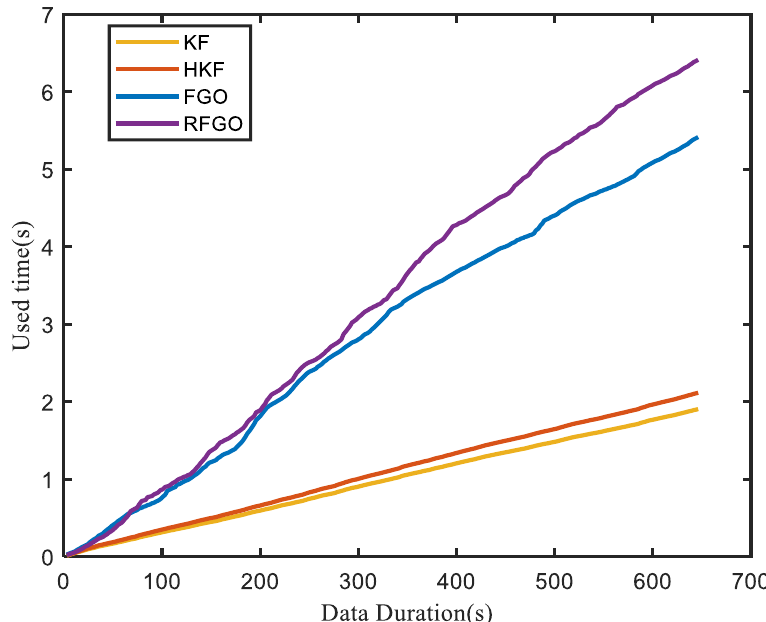
Figure 9. Execution time among different